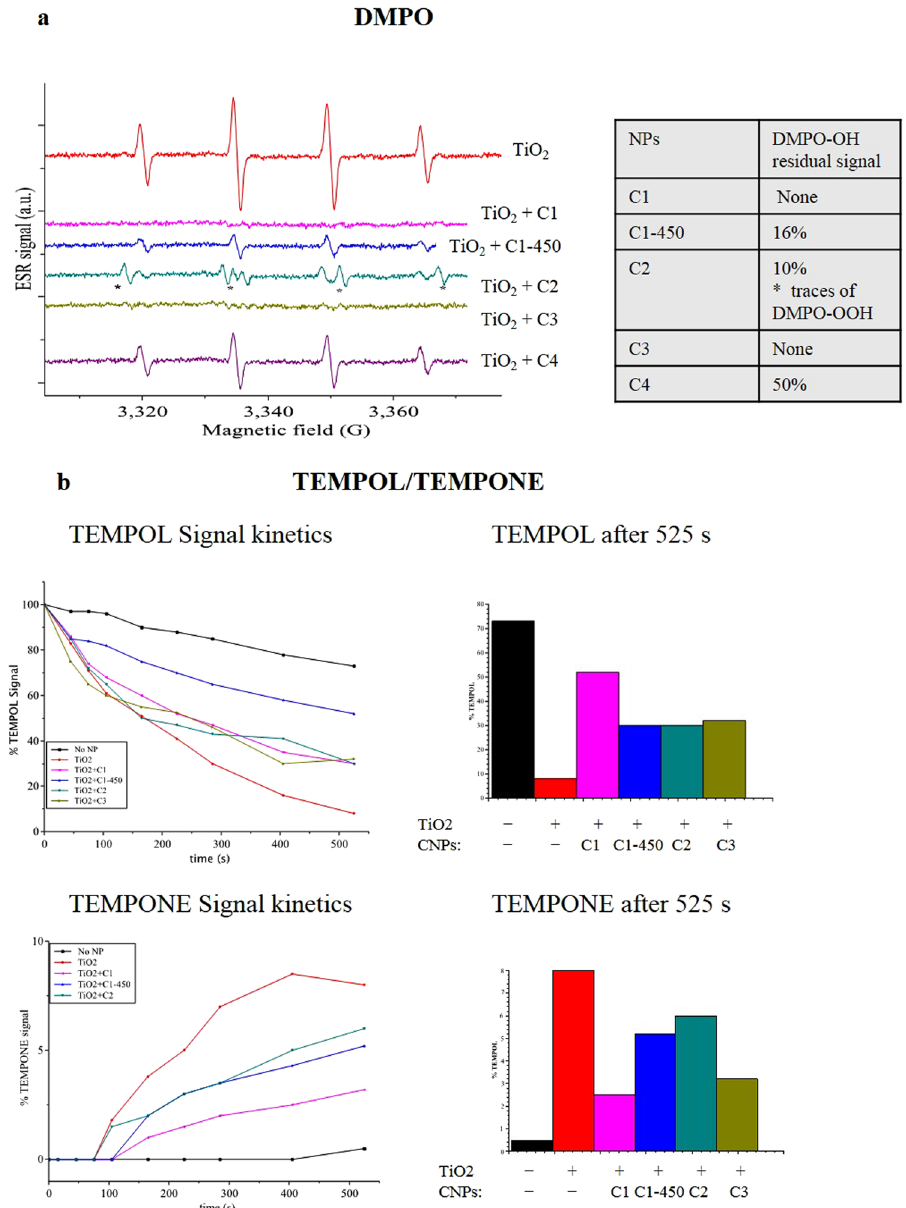
Figure 5. Abiotic analysis of CNP redox activity. ( a ) ESR spectra of DMPO spin abduct signals produced by UV-irradiated TiO 2 suspensions at 800 µ g/mL ± CNPs at 400 µ g/mL. On the right a table reporting the DMPO-OH residual signal in the presence of C1, C1–450, C2, C3, and C4 samples. ( b ) ESR analysis of TEMPOL decomposition into TEMPONE during continuous irradiation of TiO 2 (800 µ g/mL) ± CNPs (400 µ g/ mL). On the left the TEMPOL signal reduction and the TEMPONE formation kinetics for 525 s, on the right % of TEMPOL disappearance and TEMPONE formation after 525